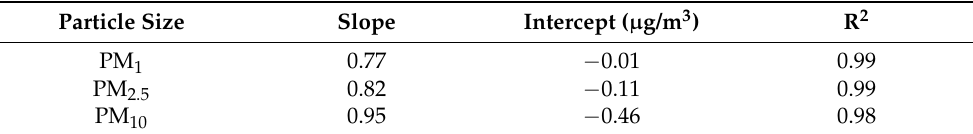
Table 1. Slope, intercept and R 2 for PM 1 , PM 2.5 , and PM 10 .